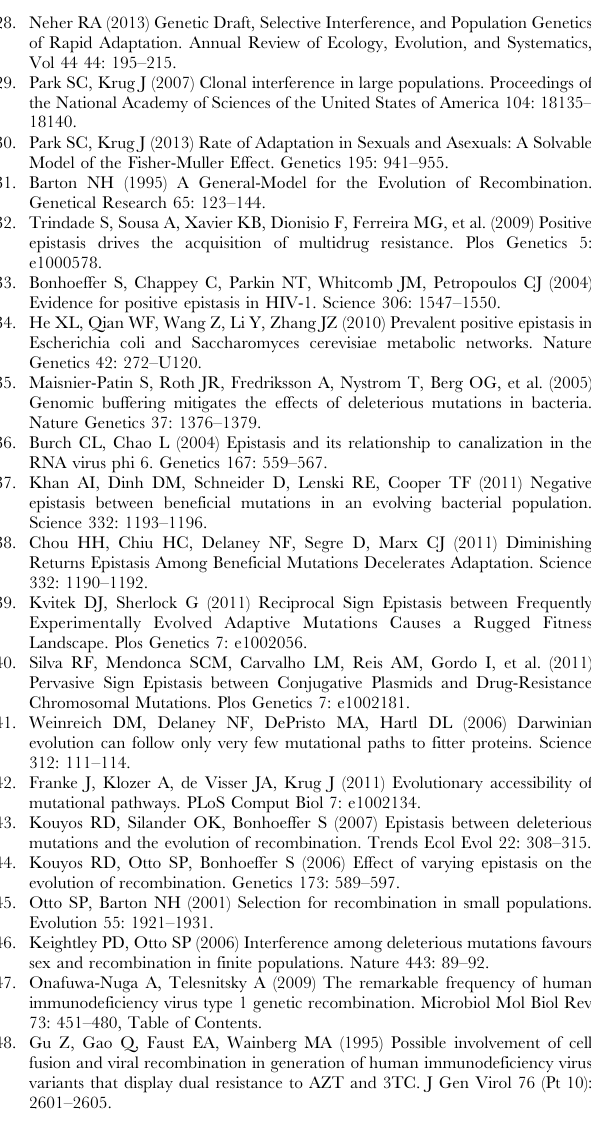
of the main and epistatic effects, respectively, are multiplied in the hierarchical fitness landscape. The plot shows the logarithm (base 10) of the ratio of the mean fitness of the recombining to that of the non-recombining populations at generation 100, averaged across 100 simulations. Parameters take the values: N ~ 10 5 and Figure S8 Invasion of the non-recombining population by the recombining type. The initial frequency of the recombining type is 1% of total the population size. The initial population is monomorphic, consisting only of the reference sequence. A) Frequency of the recombining type that invades a non-recombin- ing population during adaptation, averaged across 500 simula- tions. The shaded region shows the 95% confidence interval. Mean frequencies of the recombining population at generation 1000 across 500 simulations for different recombination rates A) mean final frequencies of the recombining population across 500